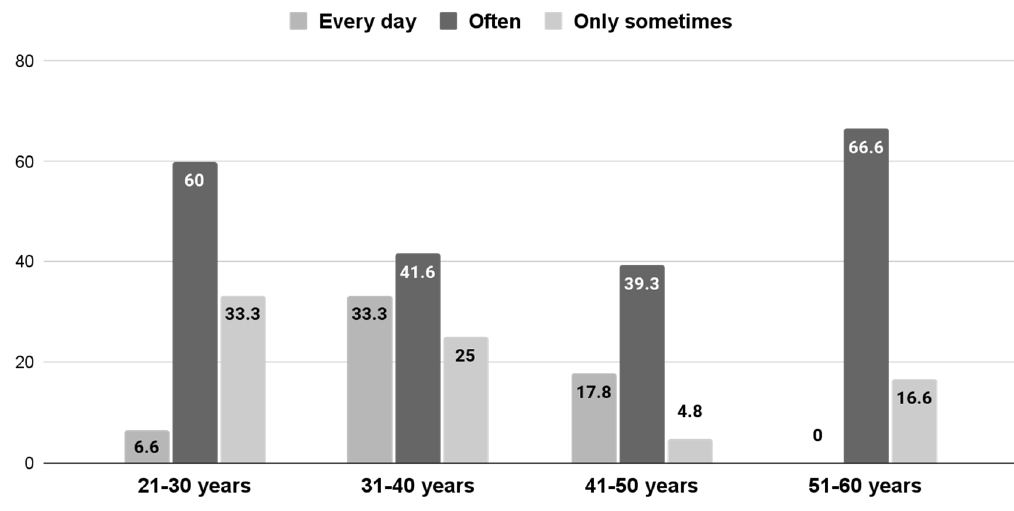
Figure 3. Frequency of use by age group in %.